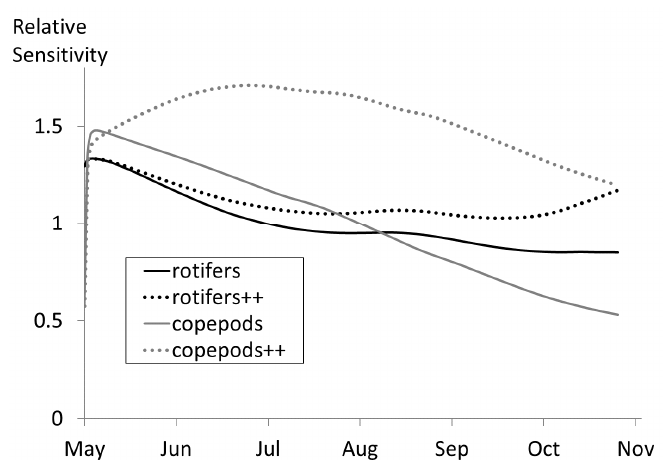
Figure 11. Results of the global sensitivity analysis when increasing (++) or decreasing (--) the initial biomass concentration of Cladocera.